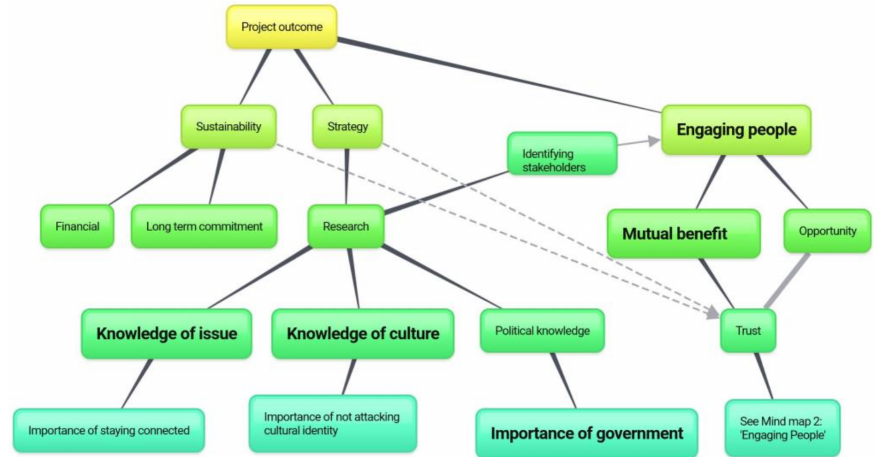
Figure 2. Tenets of successful international animal welfare initiatives. Note: Bold text indicates a frequent theme (appearing in more than 70% of interviews). A solid line indicates a strong relationship between themes, with dotted lines indicating a present relationship of significance of lower frequency (therefore strength).